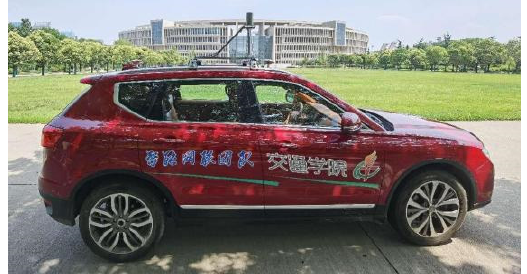
Figure 6. Experimental platform.